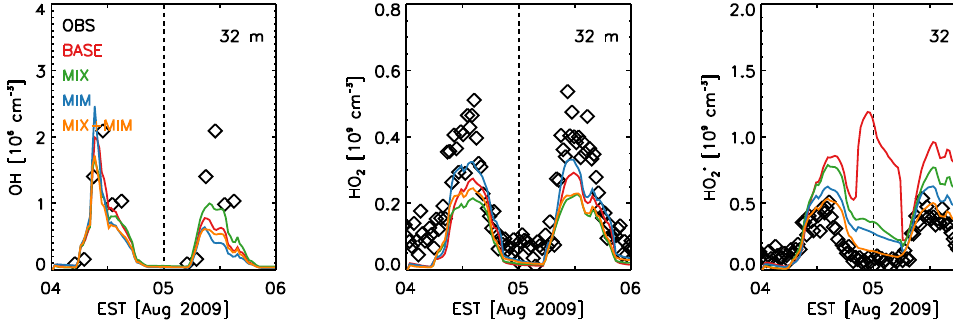
Fig. 10. Same as Fig. 5, but for OH (left), HO 2 (middle), and HO ∗